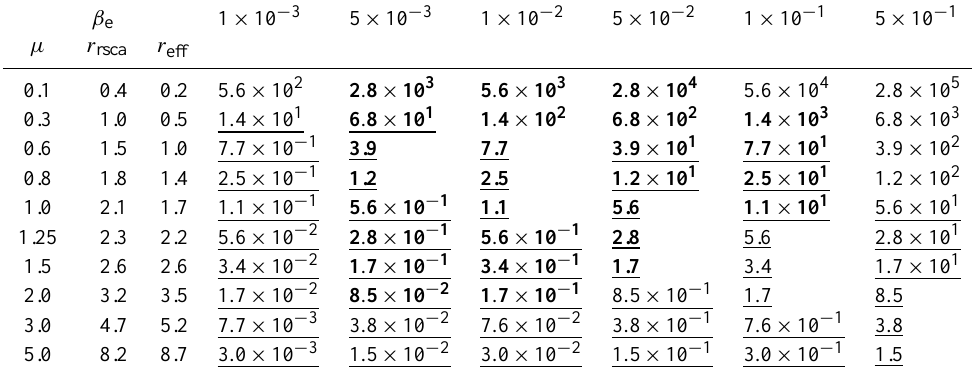
Table 4. Ash: number concentration n in cm − 3 for every median radius µ in µm and extinction coefficient β e in km − 1 . Most likely com- binations of number concentrations and particle sizes according to Mossop (1964), Farlow et al. (1981) and Schumann et al. (2011) are underlined. The number scenarios that exceed the ash detection threshold are emphasised in bold font. β e 1 × 10 −